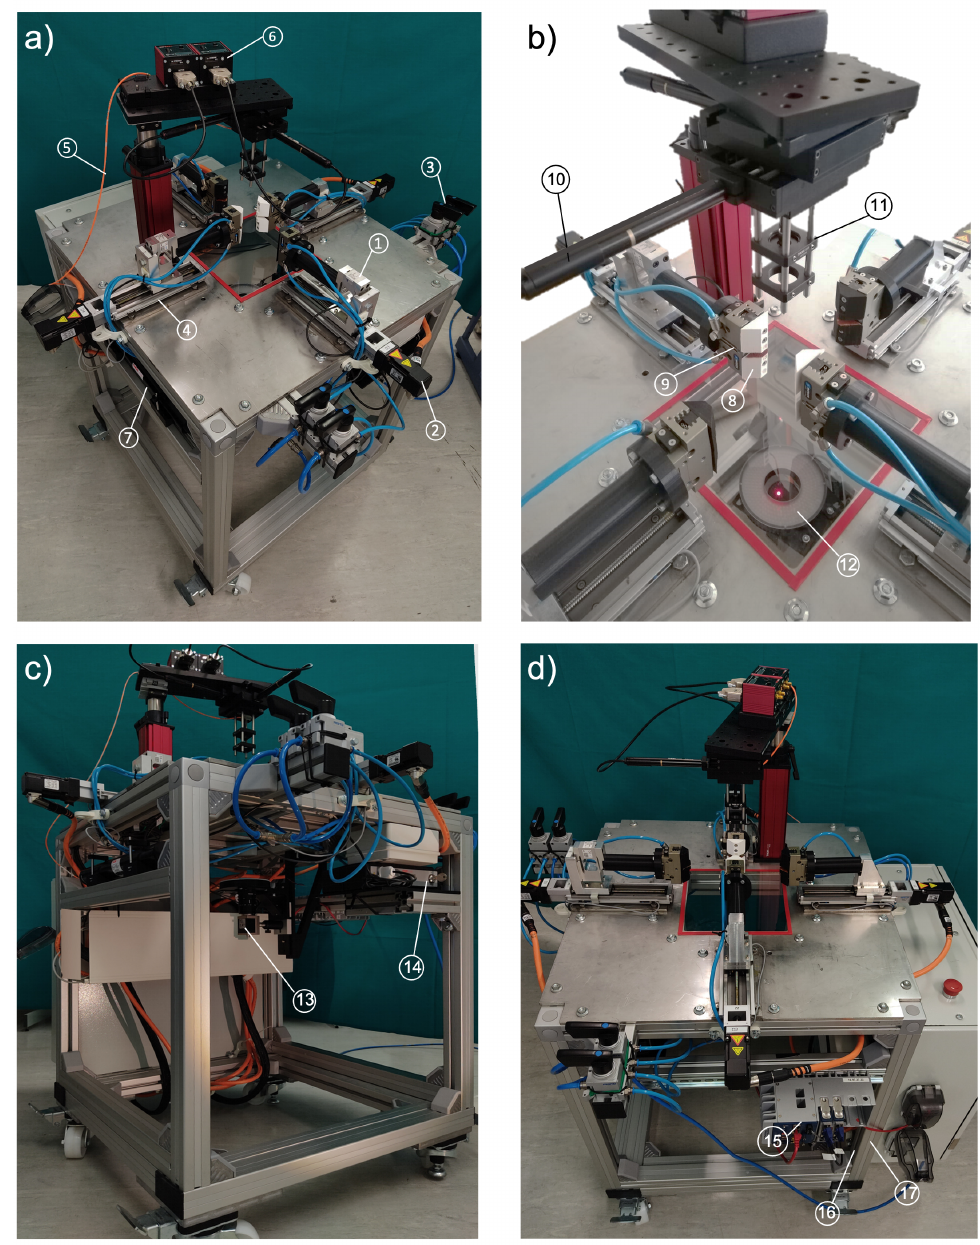
Figure 6. Different views of the OptiMech2 test bench realization with highlights on the different components. View ( a ): load cell (1), TM servomotor (2), three-way manual valves for compressed air (3), linear recirculating ball bearing guide (4), optical fiber (5), LM servo-drives (6) and laser source (7). View ( b ): gripper (8), gripper fingers (9), LM linear actuator (10), collimator-focusing lens cage (11) and annular light (12). View ( c ): camera (13) and laser interlock system (14). View ( d ): real-time controller (15) (National Instruments®), load cell acquisition module (16) and interlock signaling module